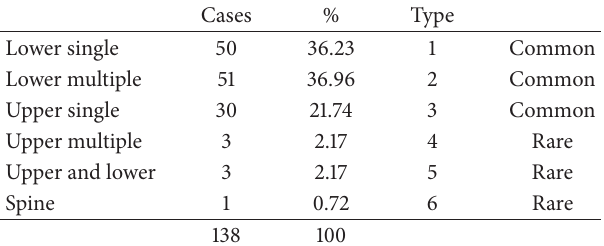
Table 4: New classification, number, and percentage of joints affected: lower or upper limb, single or